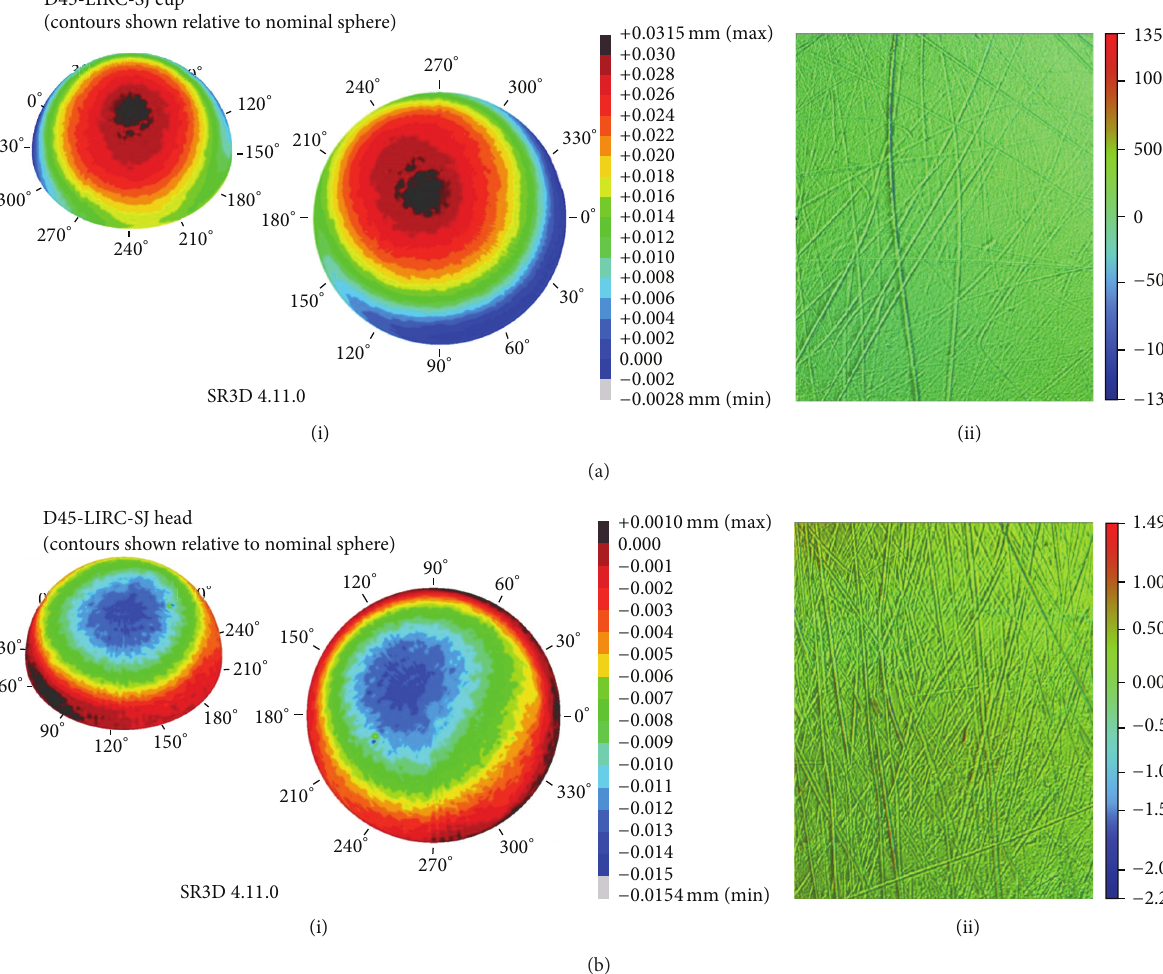
Figure 4: Graphical representation of (a)(i) cup wear profile, (a)(ii) cup surface roughness, (b)(i) femoral head wear profile, and (b)(ii) femoral head surface roughness from the LIRC